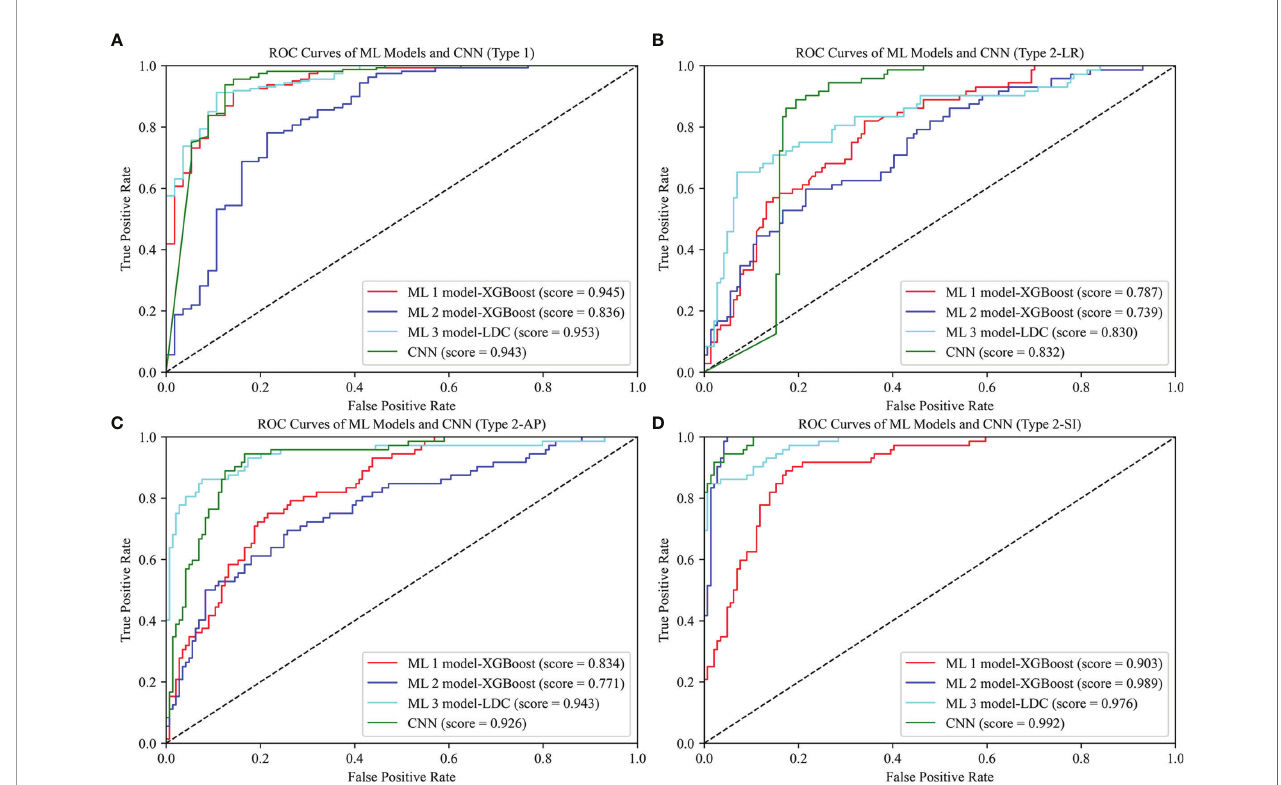
FIGURE 6 | ROC curves of ML 1 model (XGBoost), ML 2 model (XGBoost), ML 3 model (LDC), and CNN. The scores represent the AUC values corresponding to the ROC curves: (A) Type 1, (B) Type 2-LR, (C) Type 2-AP, (D) Type